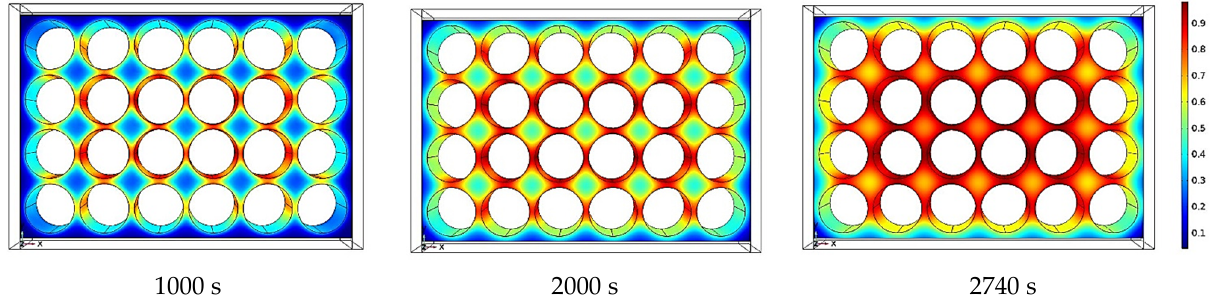
Figure 10. Liquid fraction contour of the PCM-graphite after 1000, 2000, and 2740 s under a 1.5C discharging rate.